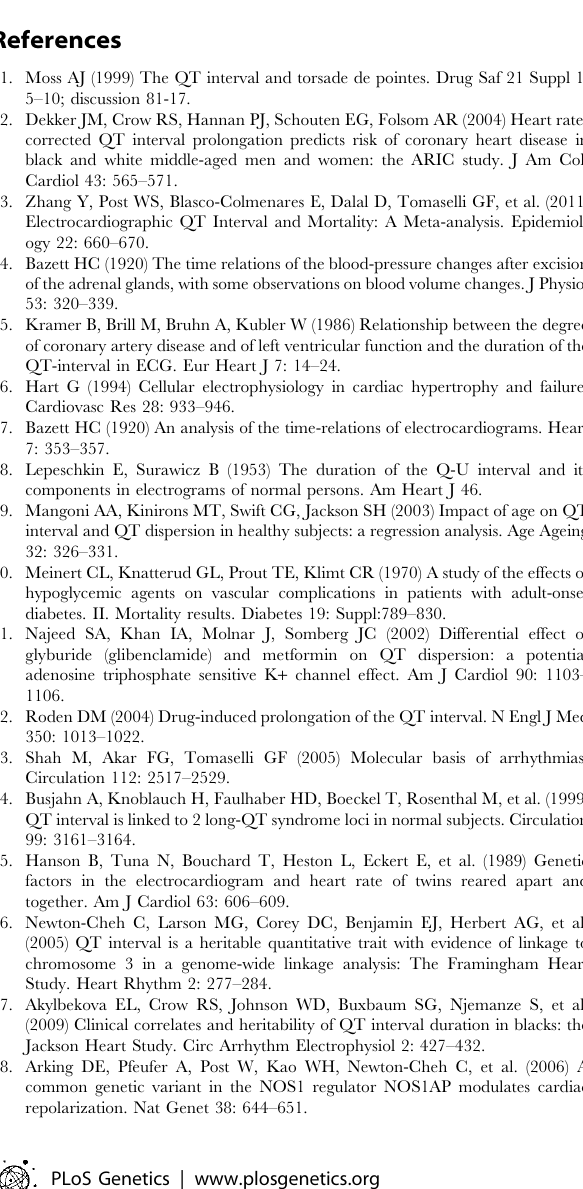
Table S2 Characterization of 11 genomic regions previously associated with QT and included on the Illumina Metabochip. Table S3 Associations with common variants at fifteen previ- ously reported QT loci across eleven chromosomes in n= 8,644 African American participants. Table S4 Associations with common variants at nine previously reported QT loci that did not generalize to n= 8,644 African American participants. Table S5 Genomic datasets used for bioinformatic character- ization of QT loci. Table S6 Bioinformatic characterization, predicted function, and correlation with index SNP for nine SNPs associated with QT detected in n =8,644 African American participants.